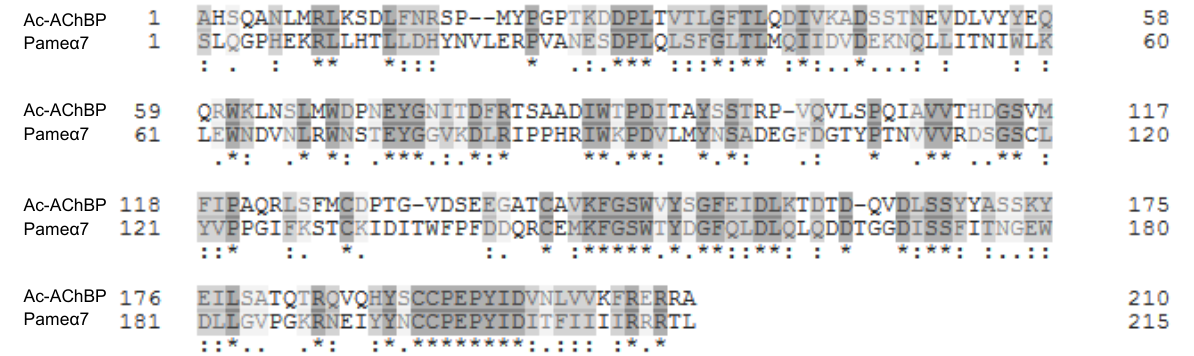
Figure 5. Sequence alignment of Ac-AChBP and cockroach Pame α 7 receptor used to generate the homology model. (*) indicate conserved residues. (:) and (.) indicate conserved and semi-conserved substitutions.